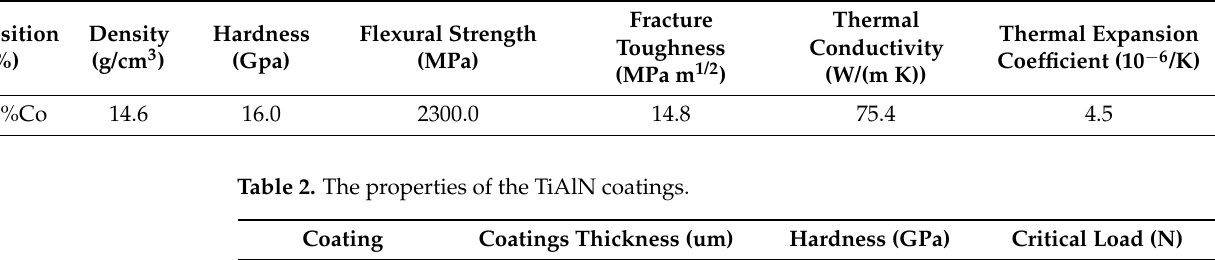
Table 1. Properties of the WC/Co cemented carbide materials.